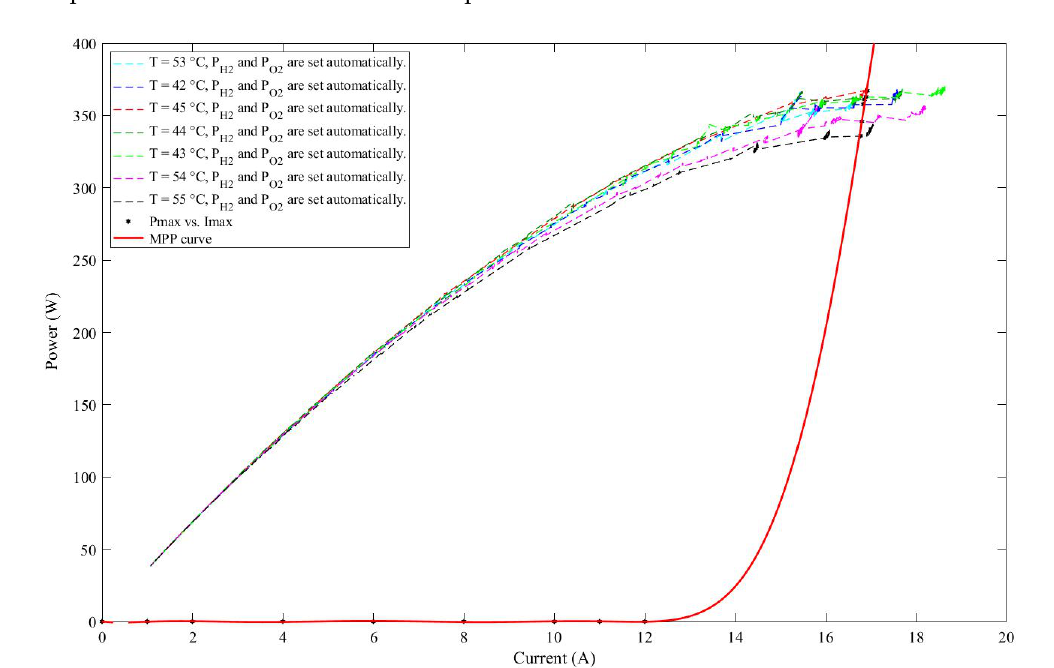
Figure 7. P-I polarization curves at different operating temperatures.